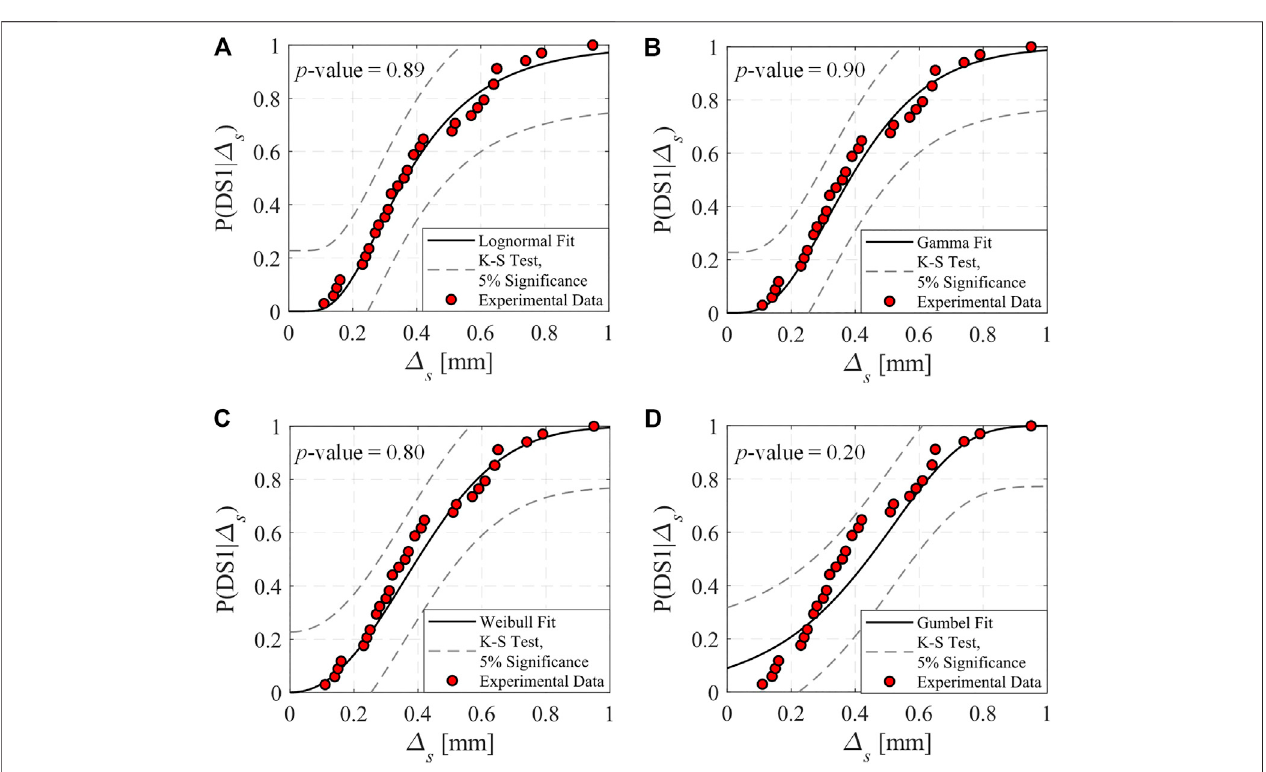
FIGURE4| Comparison offourtheoreticalCDFs fi ttedtotheempiricallyderivedCDF fordamagestateDS1 (A) lognormal (B) gamma (C) Weibulland (D) Gumbel.